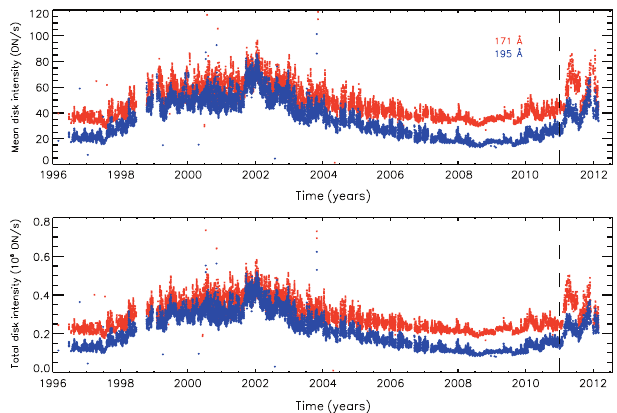
Fig. 6. Mean (top panel) and total (bottom panel) of the daily on- disk pixel intensities of the 171 Å (red) and 195 Å (blue) EIT images. Early in 2011 (indicated with the vertical dashed line), the time series shows a significant increase in mean and total intensity for both channels. Therefore, EIT data taken after 31 December 2010 have been excluded from the